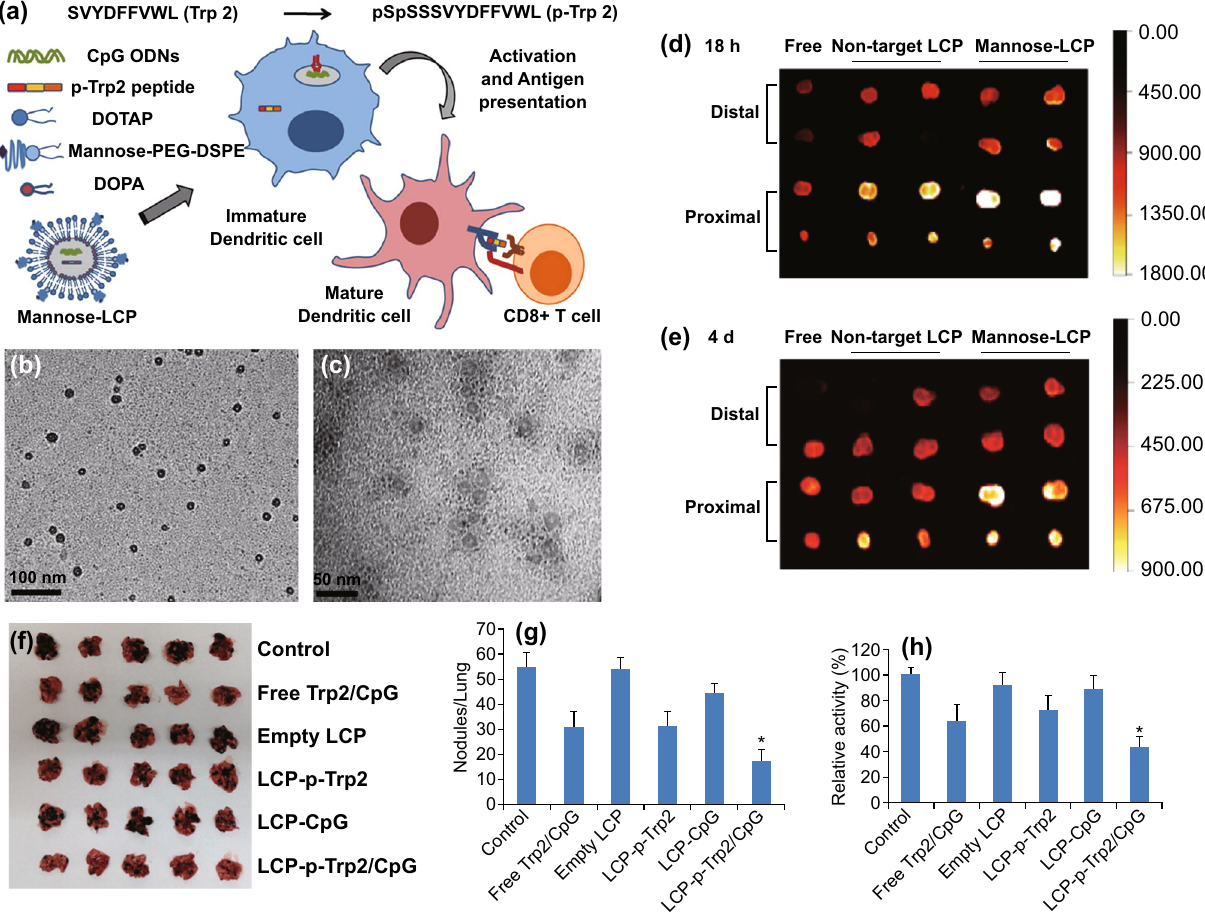
Fig. 3 a Mannosylated LCP-nanoparticle (MN-LCP-NP)-based vaccine for dendritic cell (DCC) activation. DC activation results in inducing cytotoxic T-cell-mediated immune response. TEM microphotographs of b mannosylated nanoparticles and c p-Trp2 peptide and CpG ODN- loaded MN-LCP-NP. Scaling = 100 nm and 50 nm respectively. d Biodistribution in lymph nodes of the vaccine formulation upon s.c adminis- tration in C57BL/6 mice containing 125 I-labeled p-Trp2 peptide and Texas Red-labeled ODN. Free: in 5% glucose; Non-target LCP-NPs, MN- LCP-NP, LCP NPs without DSPE-PEG-Mannose; and with DSPE-PEG-Mannose. Readings noted after 18 h and e after 4 days. f Lungs isolated from C57BL/6 mice with B16F10-luc cells induced lung metastatic melanoma after being treated with different formulations. g Tumor nodules h luciferase activity in lungs (n = 5, * P < 0.05). Adapted from with permission from Ref. [254] Elsevier, Copyright